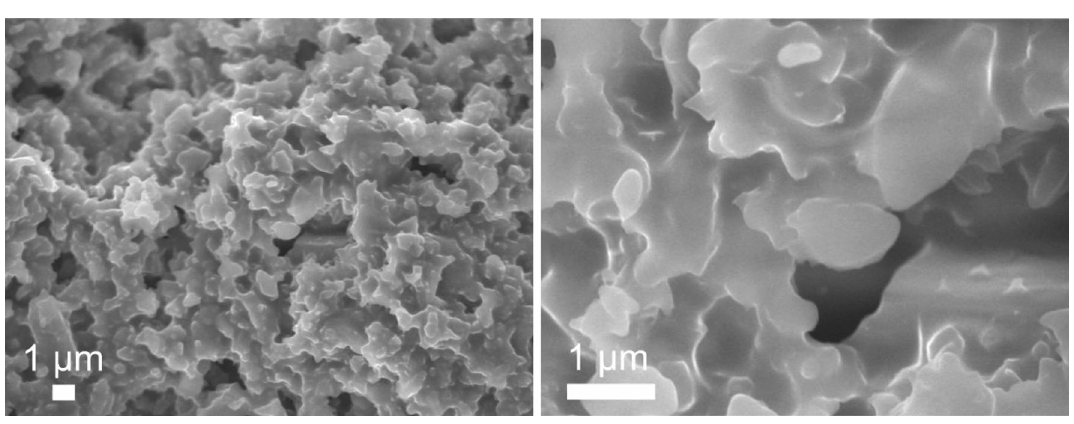
Figure 3. SEM images of bis(5-chloroquinolin-8-olato)-bis(pyridine)-cobalt(II)